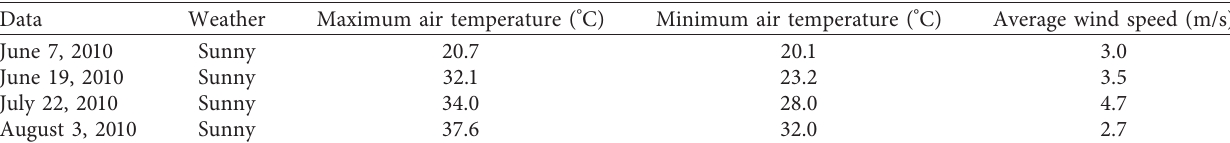
Table 2: Weather conditions of the four sunny days.